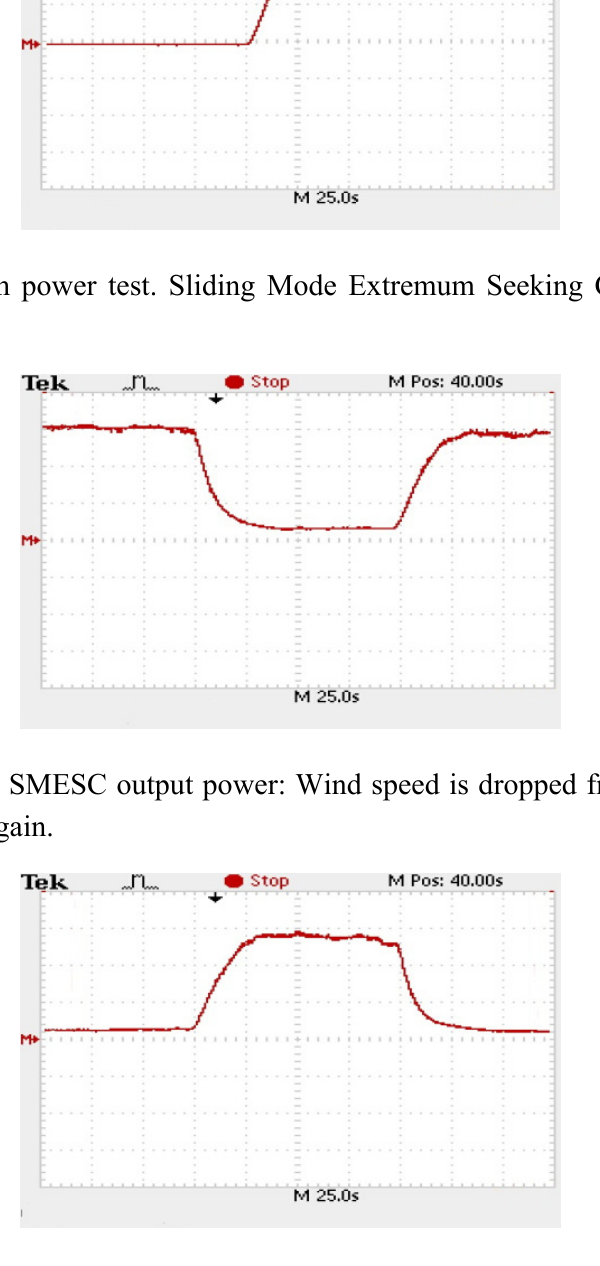
Figure 17. Measured SMESC output power: Wind speed is raised from 5 to 8 m/s, and then dropped back to 5 m/s